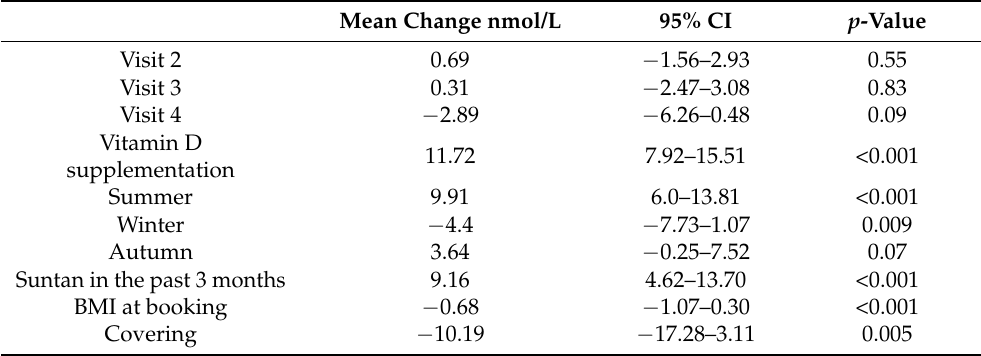
Multivariable linear regression analysis for factors influencing vitamin D levels during